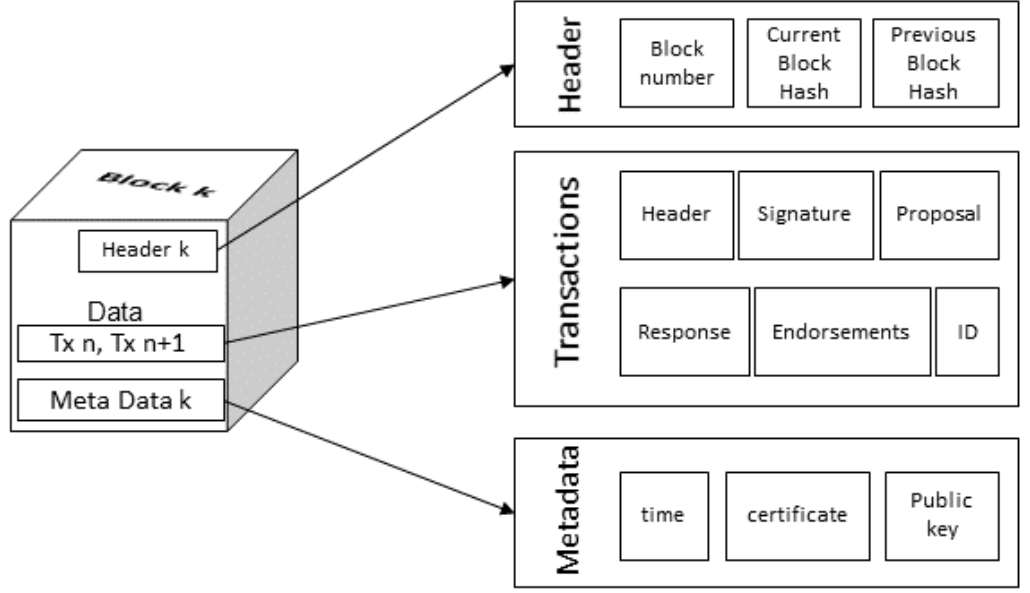
Figure 3. White box diagram of a